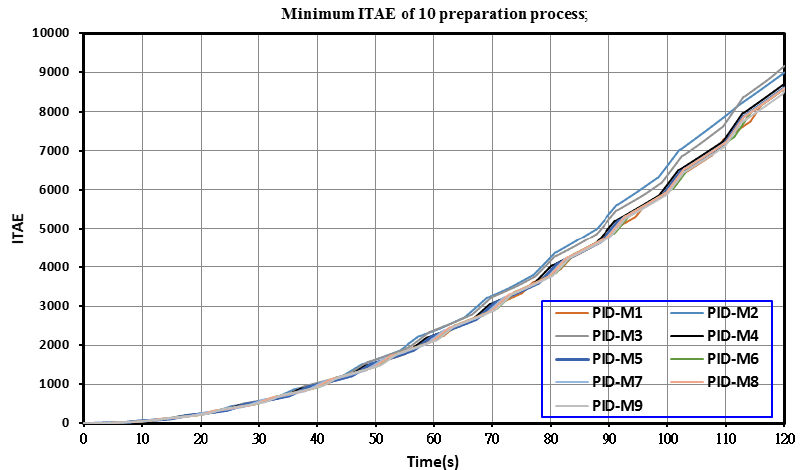
Figure 7. Minimum ITAE values for the production of TiO 2 nanocolloids by using nine PID controllers designed using the root locus method.